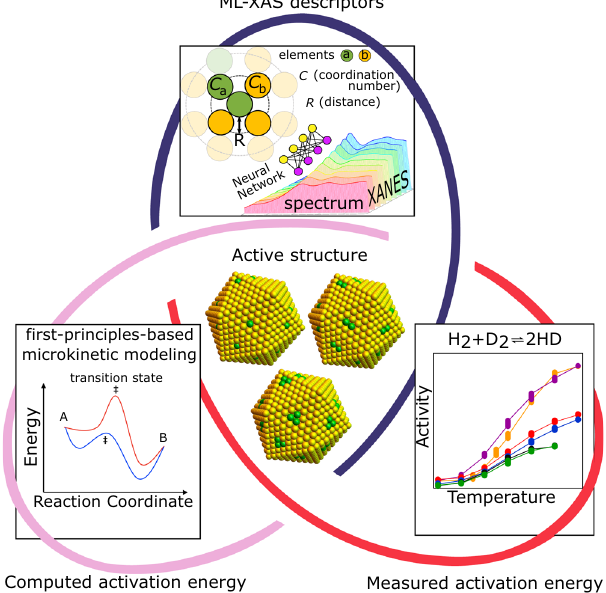
Fig. 1 Multipronged strategy for decoding reactive structures. Measured X-ray absorption spectra are correlated directly to catalytic activity via theoretical modeling. (ML-XAS descriptors panel) Local structural descriptors, such as coordination number (C) and interatomic distance (R) between elements a (green) and b (yellow), are extracted from X-ray absorption spectra through machine learning (ML-XAS), via the Neural Network, to constrain the set of candidate active sites. (Computed activation energy panel) The corresponding reaction pathways, from states A to B through the transition state ‡ , are modeled using fi rst-principles- based microkinetic modeling. (Measured activation energy panel) Apparent activation energies from computations are compared to experimental measurements, where colors represent different reaction starting conditions of the hydrogen (H) deuterium (D) exchange reaction (H 2 + D 2 ⇋ 2HD), to further narrow down the dominant active sites. (Active structure panel) Three possible nanoparticle motifs are shown where the active sites are green and vary between 1 and 3